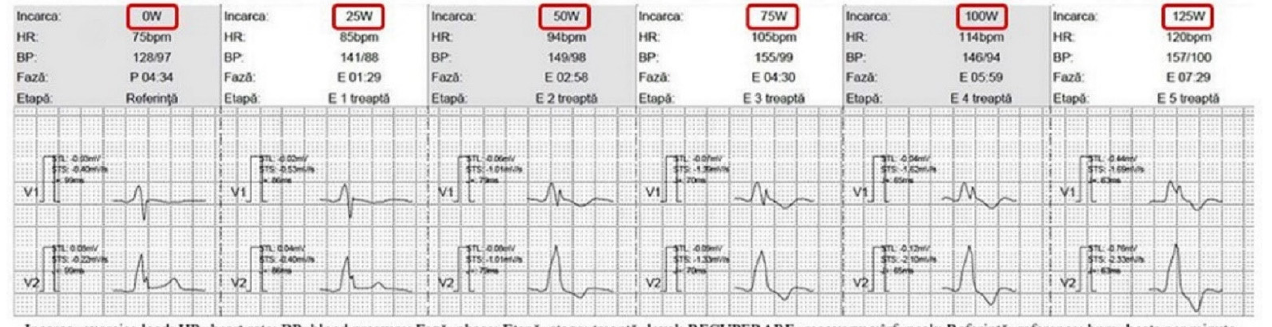
Figure 2. During exercise, a lengthening of PR interval leads to complete LV capture—RBBB appearance in V1, V2.